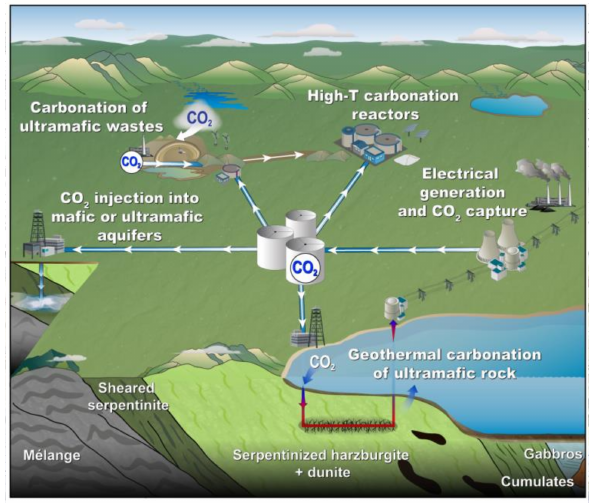
Figure 1. Conceptual diagram depicting geoengineering system designed for CCS process via mineral carbonation. Modified from Power et al.